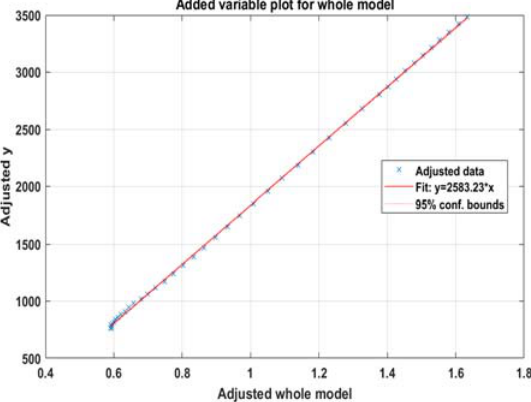
Figure 4. Model for (6) with hospitalizations for the whole